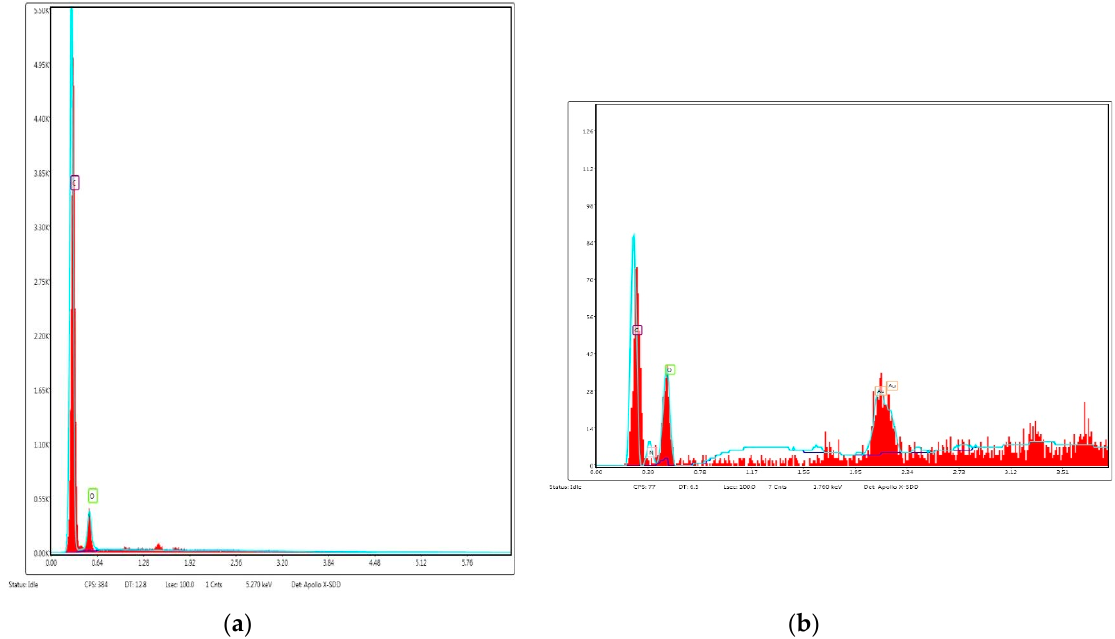
Figure 4. Selected energy-dispersive X-ray (EDX) spectra of ( a ) PUR/5PLA/0C and ( b ) PUR/5PLA/5C.